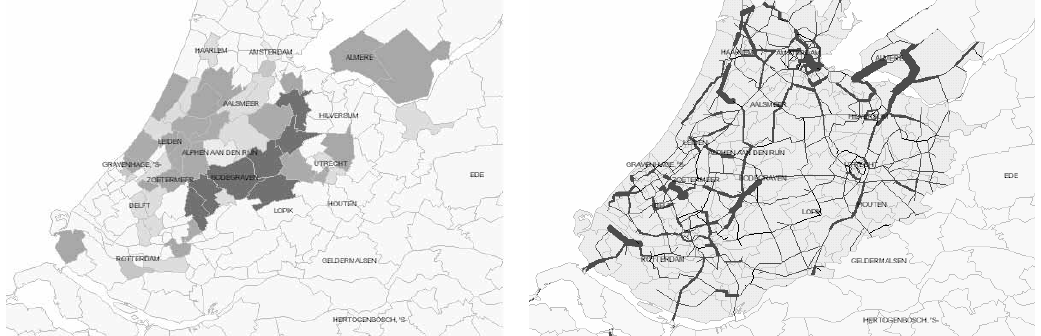
Figure 8. Example of spatial and infrastructure maps (mutations inhabitants and congestion)